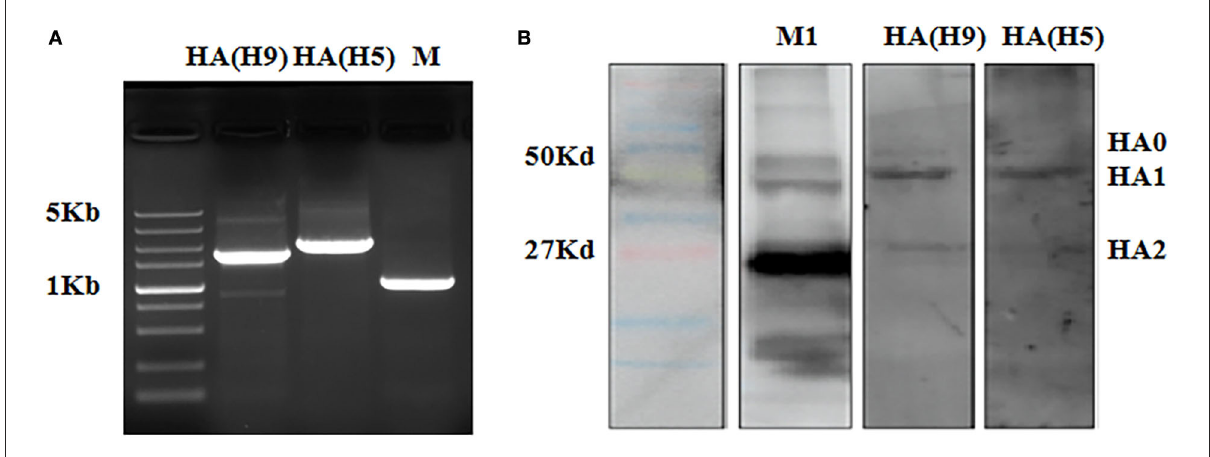
FIGURE4 HAs of H9 and H5 were verified in the recombinant WM01ma-HA (H5) influenza virus by RT-PCR (A) and western blotting (B) .